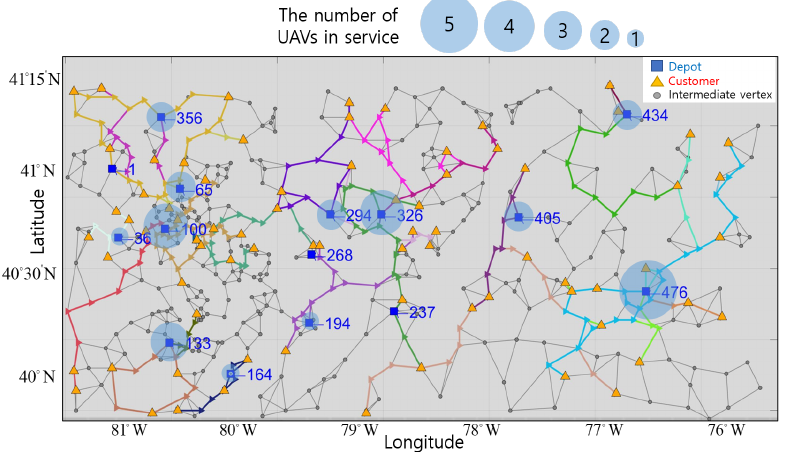
Figure 9. Round-trips of UAVs in the situation that a single UAV can deliver to a